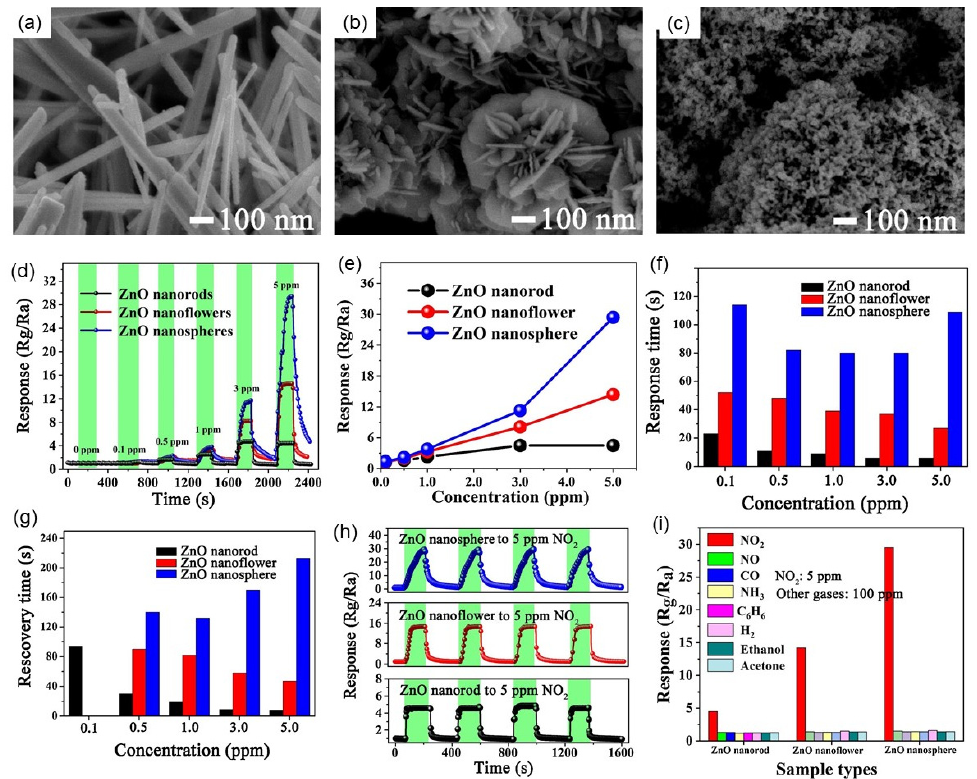
Figure 8. SEM images of ( a ) ZnO nanorods, ( b ) ZnO nanoflowers and ( c ) ZnO nanospheres. ( d ) Dynamic response curves with time of three different ZnO nanostructures; ( e ) the response curves with NO 2 concentration of three different ZnO nanostructures; ( f , g ) the response and recovery time of three different ZnO nanostructures; ( h ) the repeatability of three different ZnO nanostruc- tures to 5 ppm NO 2 ; ( i ) the selectivity of three different ZnO nanostructures to other harmful gases. Reprinted with permission from Ref. [130]. Copyright 2021